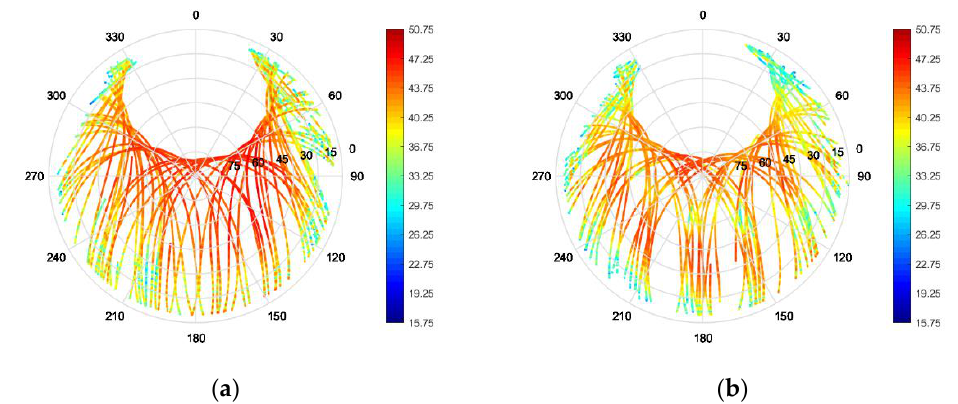
Figure 13. GNSS field measurements of the antenna array. Sky plot of C/N0 in dB of received GNSS signals at L1/E1 band over a 24-h time window. ( a ) Antenna array standalone; ( b ) Antenna array mounted on UAV.